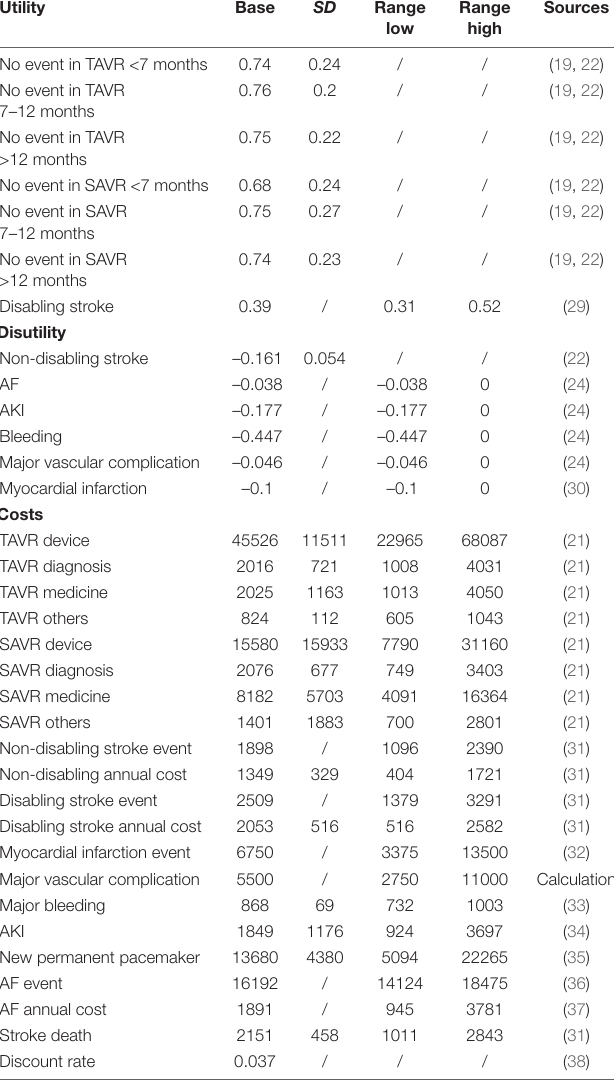
TABLE 2 | Utilities and costs in the model.